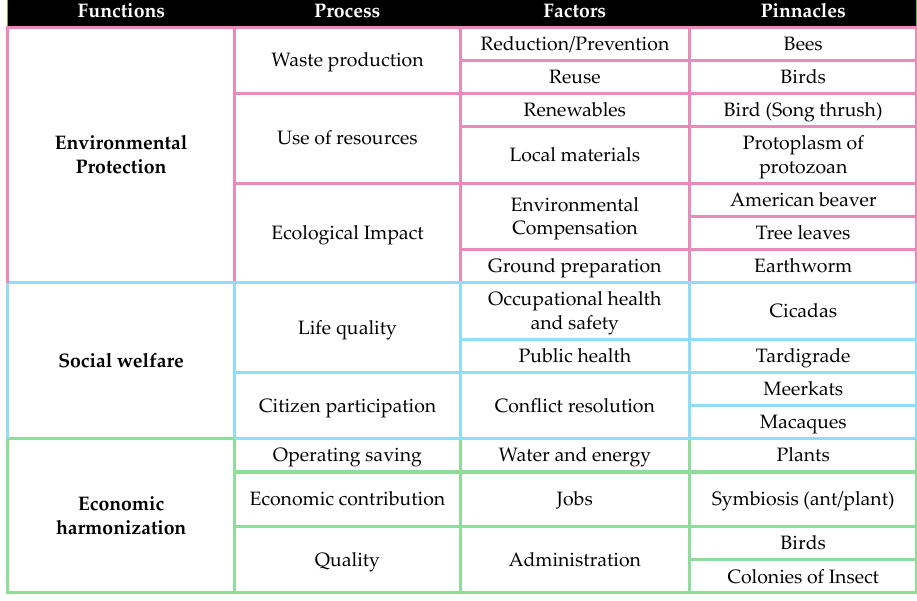
Figure 5. Selected pinnacles from the exploratory